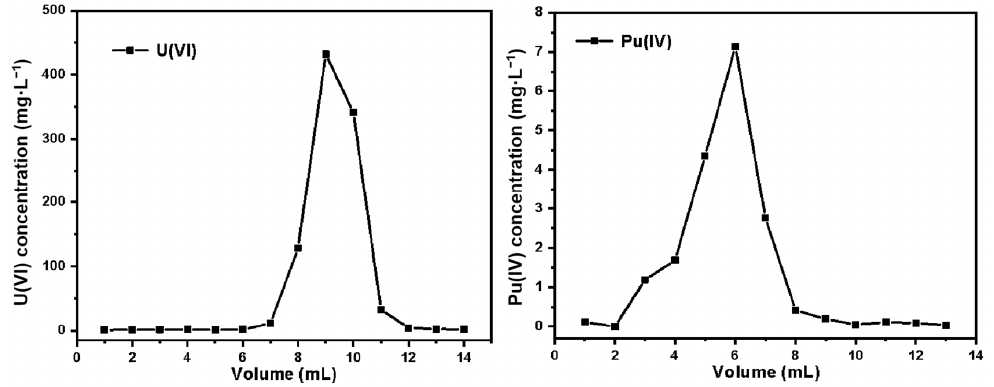
Figure 21. Elution curves for uranium and plutonium.